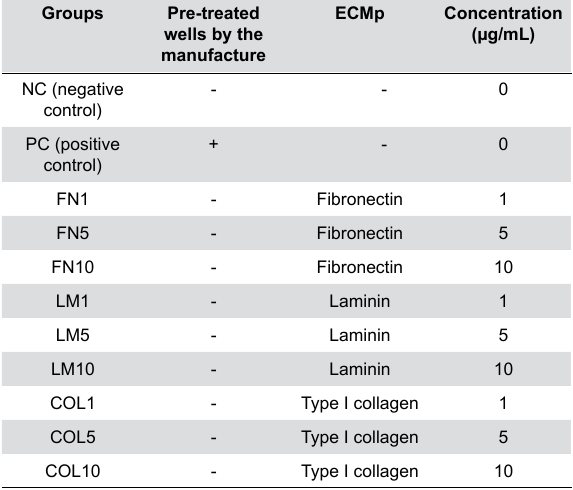
Table 1- Experimental and control groups according to type of polystyrene 96-well plate and type and concentration of extracellular matrix protein